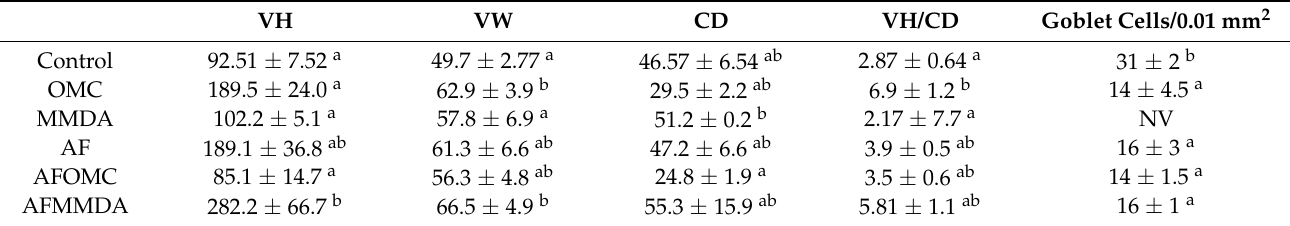
Table 5. Histology of the intestine of Nile tilapia.